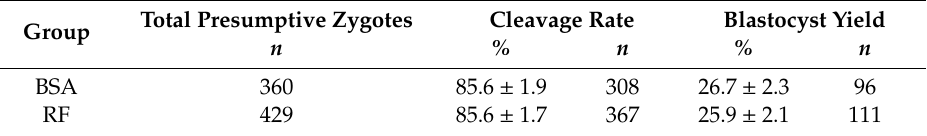
Table 1. Total presumptive zygotes, cleavage and blastocyst rate of in vitro produced embryos bovine serum albumin (BSA) or reproductive fluids (RF). Group